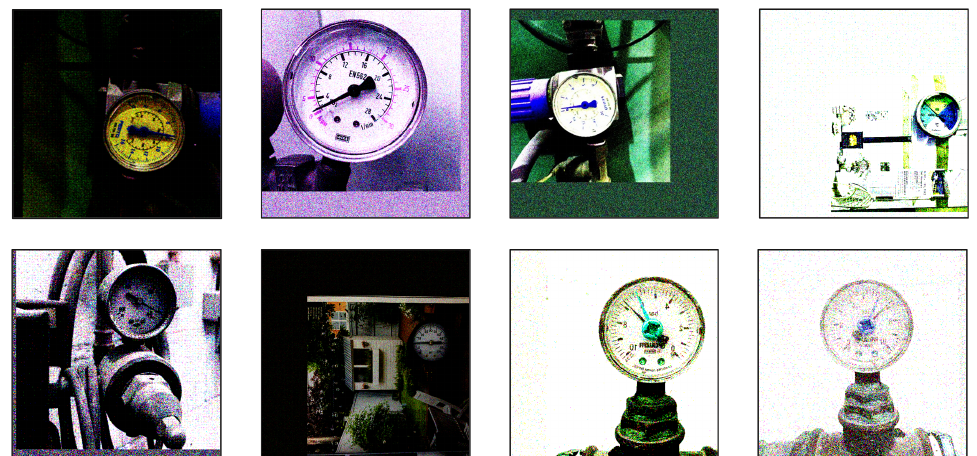
Figure 3. Examples of the data augmentation applied to some dataset images.